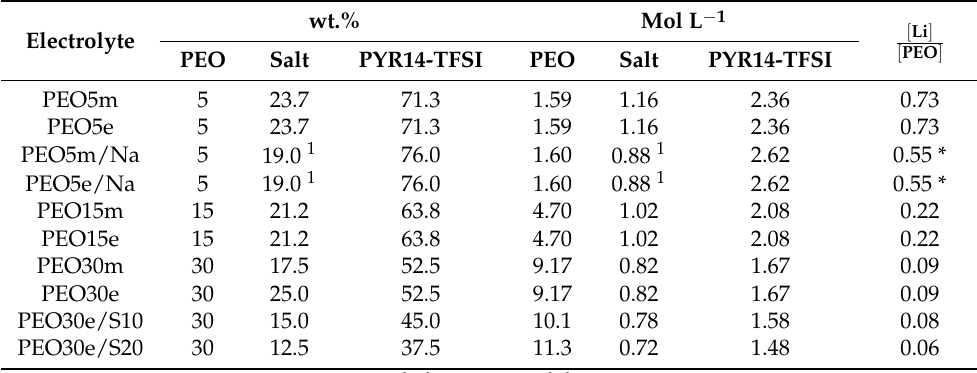
Table 1. Composition and nomenclature of the electrolytes